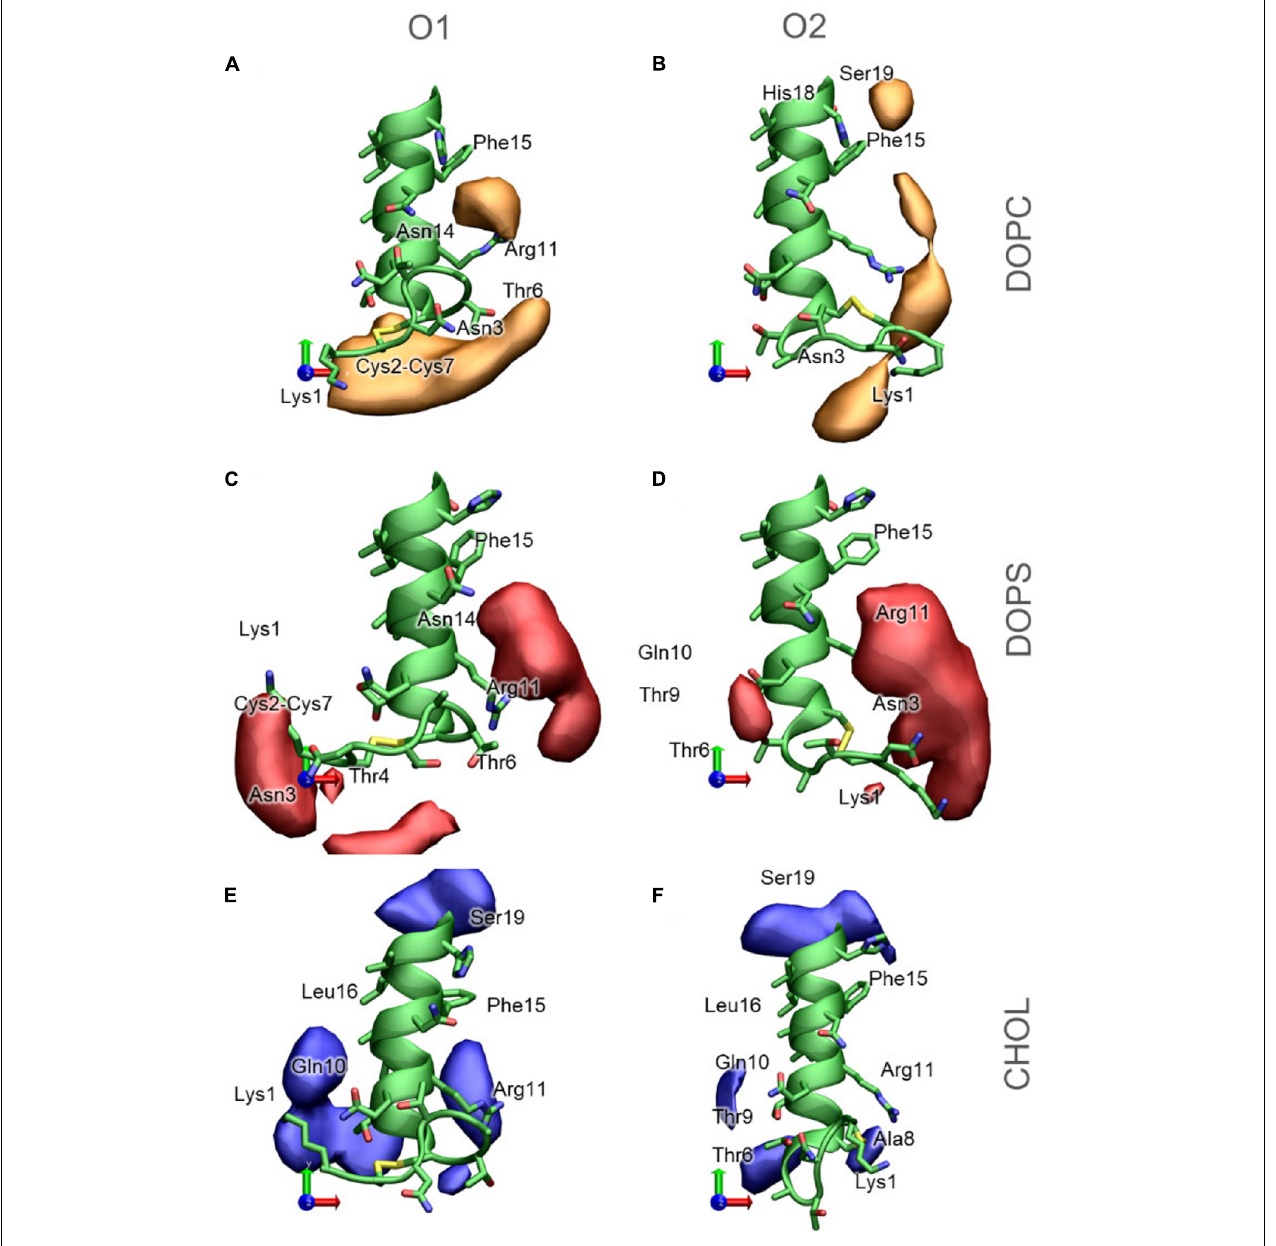
FIGURE 11 | 3D Occupancy maps of the lipids around IAPP 1 − 19 , depending on the orientation of the N-terminal loop (A) DOPC around IAPP O 1 (B) DOPC around IAPP O 2 (C) DOPS around IAPP O 1 (D) DOPS around IAPP O 2 (E) CHOL around IAPP O 1 (F) CHOL around IAPP O 2 . IAPP 1 − 19 is shown in green, and selected residues are